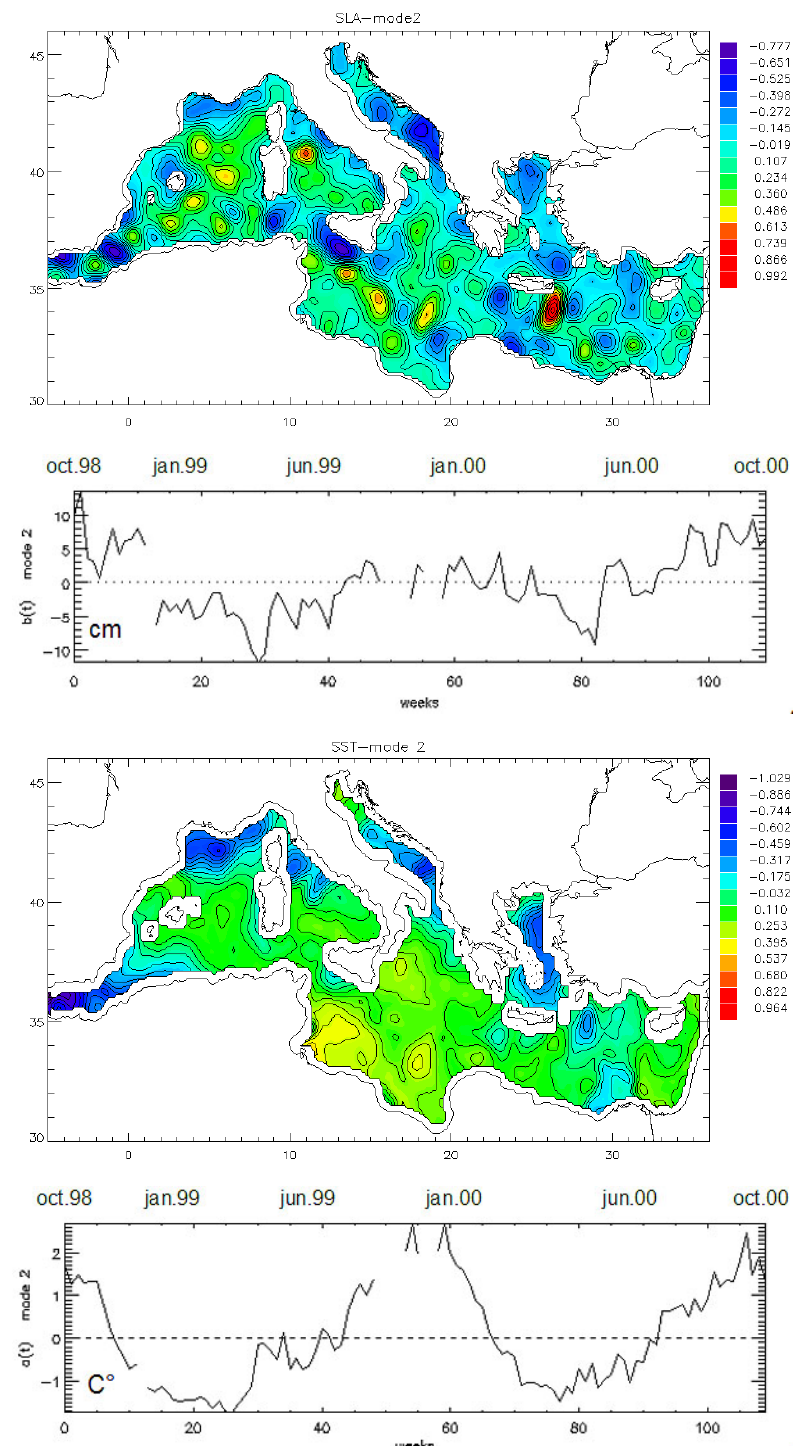
Fig. 7. Second “gradient CPA” mode of SLA and SSTA data collected during. Patterns and associated temporal coefficients: (a) SLA pattern, (b) SLA temporal coefficient, (c) SST pattern, (d) SST temporal